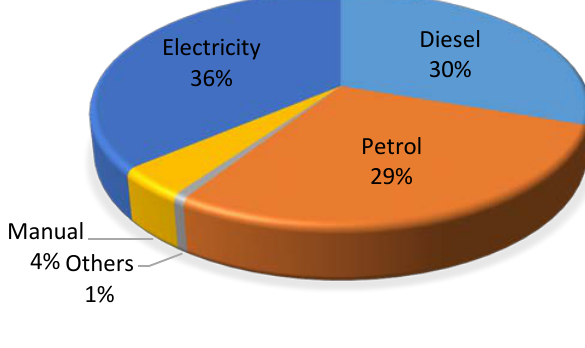
Figure 5. Energy mix of the study